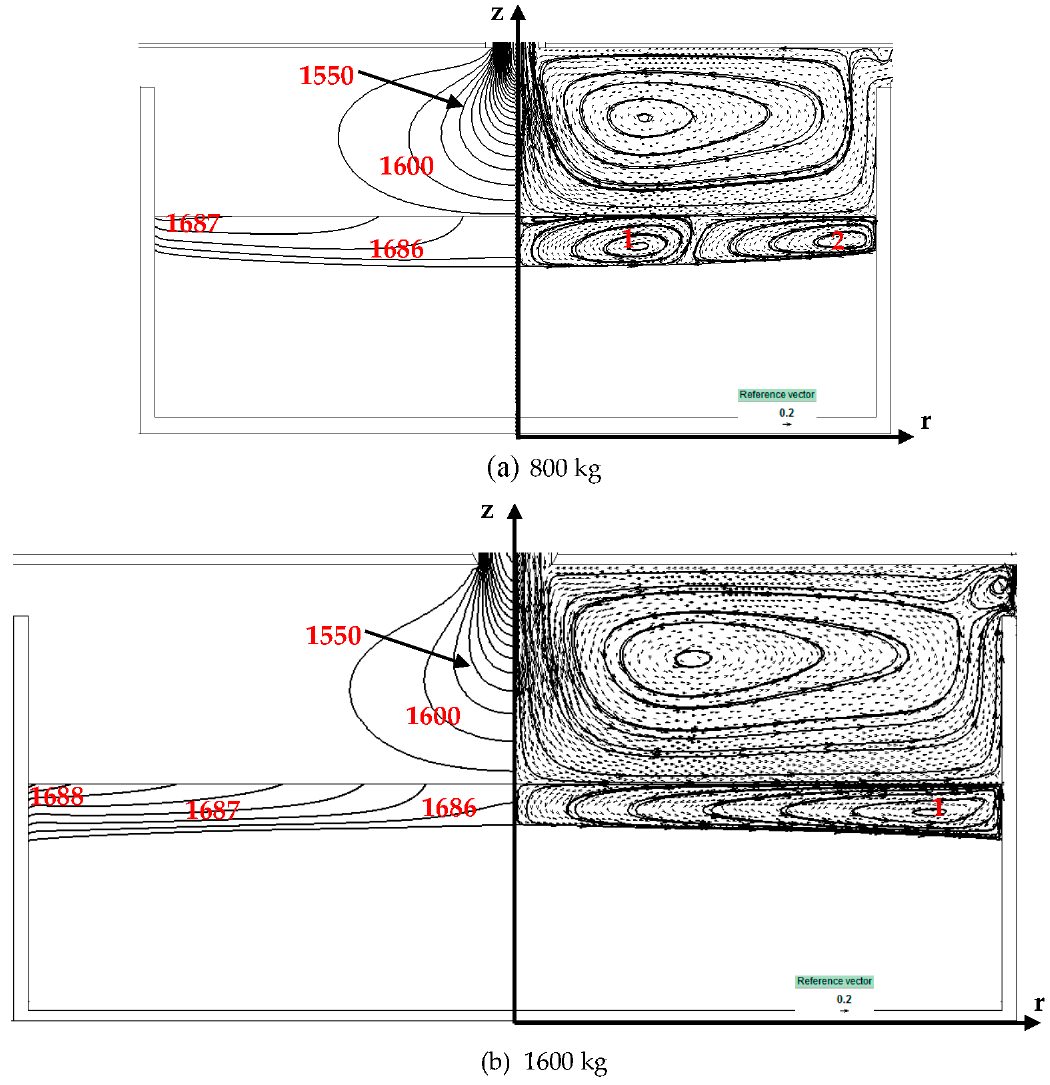
Figure 3. Distribution of temperature ( left , ∆ T = 0.5 K (in melt), ∆ T = 50 K (in gas)) and flow structure ( right ) in the silicon melt and argon gas at a solidification fraction of 70% with different silicon feedstock capacities: ( a ) 800 kg; ( b ) 1600 kg.